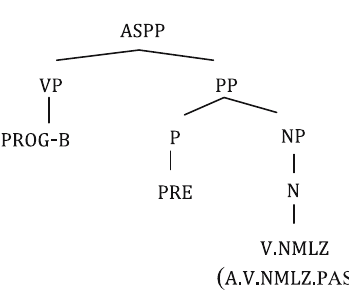
Figure 1: Reconstructed structure of the progressive in Proto